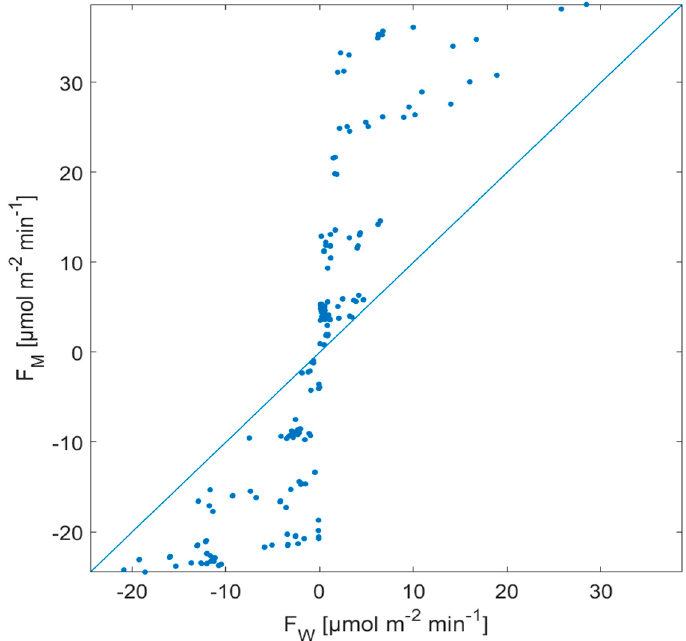
Figure 3. Comparison between a zero intercept parameterization following Wanninkhof [3] (F W ) and the nonzero intercept parameterization proposed in this study (F M ). The nonzero intercept parameterization resulted from a least squares regression fit to gas transfer velocity versus wind speed. Fluxes for both parameterizations were calculated with the ancillary data from the measurement campaigns presented in Table 1. The line of perfect agreement (1:1 line) is also shown.